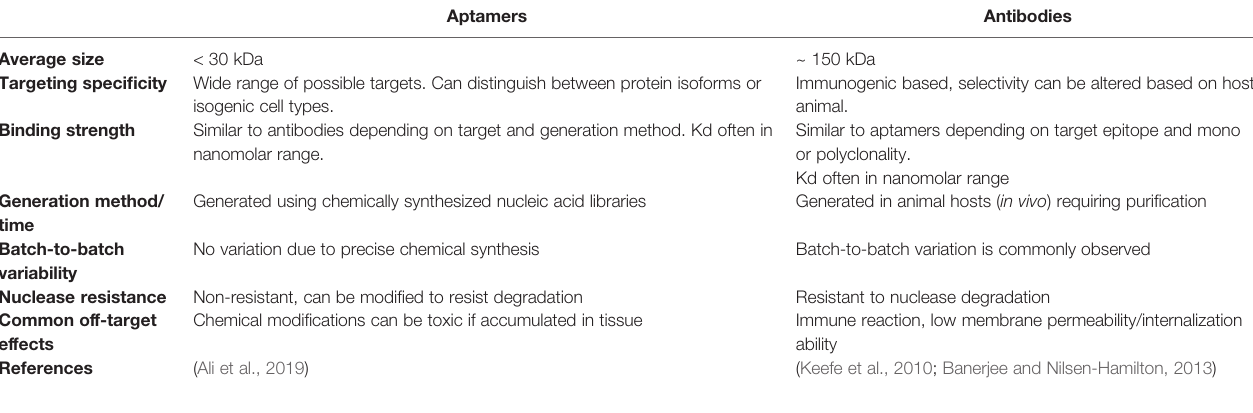
TABLE 1 | Characteristics required for tumor targeting agents; comparison of nucleic acid aptamers and antibody-based therapeutics.